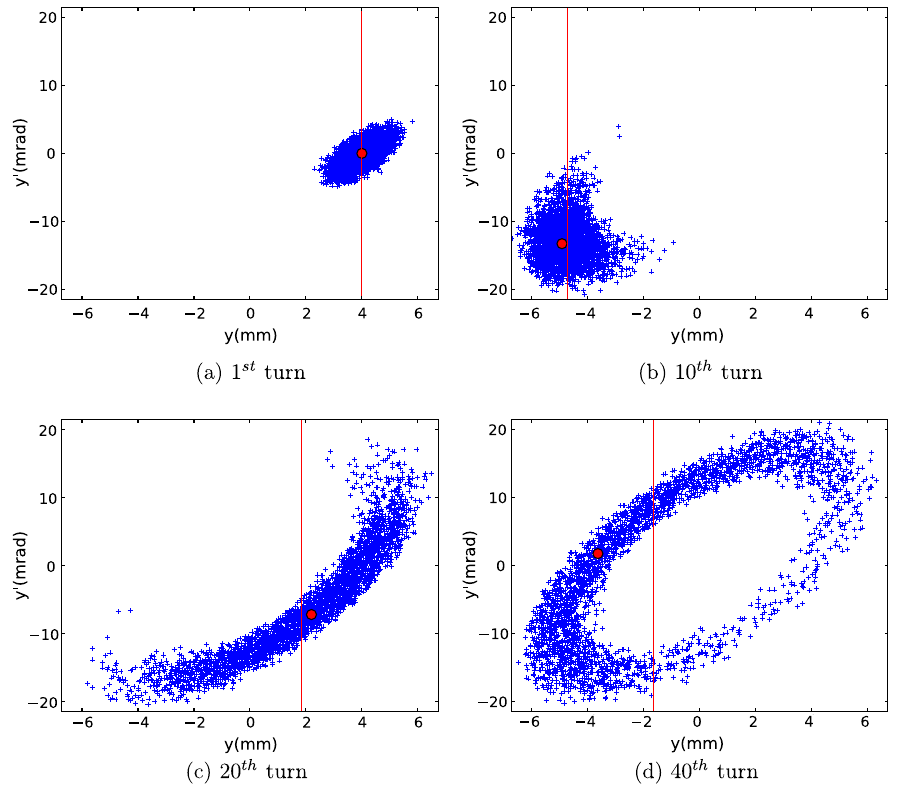
FIG. 2. Simulations showing the decoherence of a particle bunch in horizontal transverse phase space. A total of 4000 particles, with a Gaussian momentum distribution ( σ ¼ 50 keV = c) around the central momentum of 12 . 1 MeV = c, are tracked through the EMMA lattice using Z GOUBI . The bunch centroid has an initial horizontal offset of 4 mm from the closed orbit position. Blue points show the location in phase space of individual particles, the single red point shows the position of an on momentum particle which, at injection, is located at the center of the bunch, and the red line shows the bunch center of mass (mean y position) for the specified